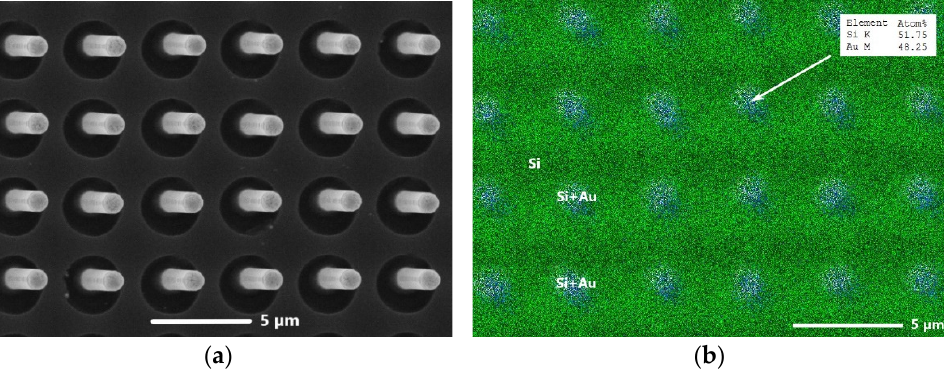
Figure 1. Electron microscopy image ( a ) and element mapping image ( b ) of a silicon substrate with a regular system of Si whiskers of the same height with Si-Au globules at the tops (view at an angle of 30° from the normal to the substrate surface). The inset in ( b ) shows the Au and Si contents in at.% at the top of one of the Si whiskers.